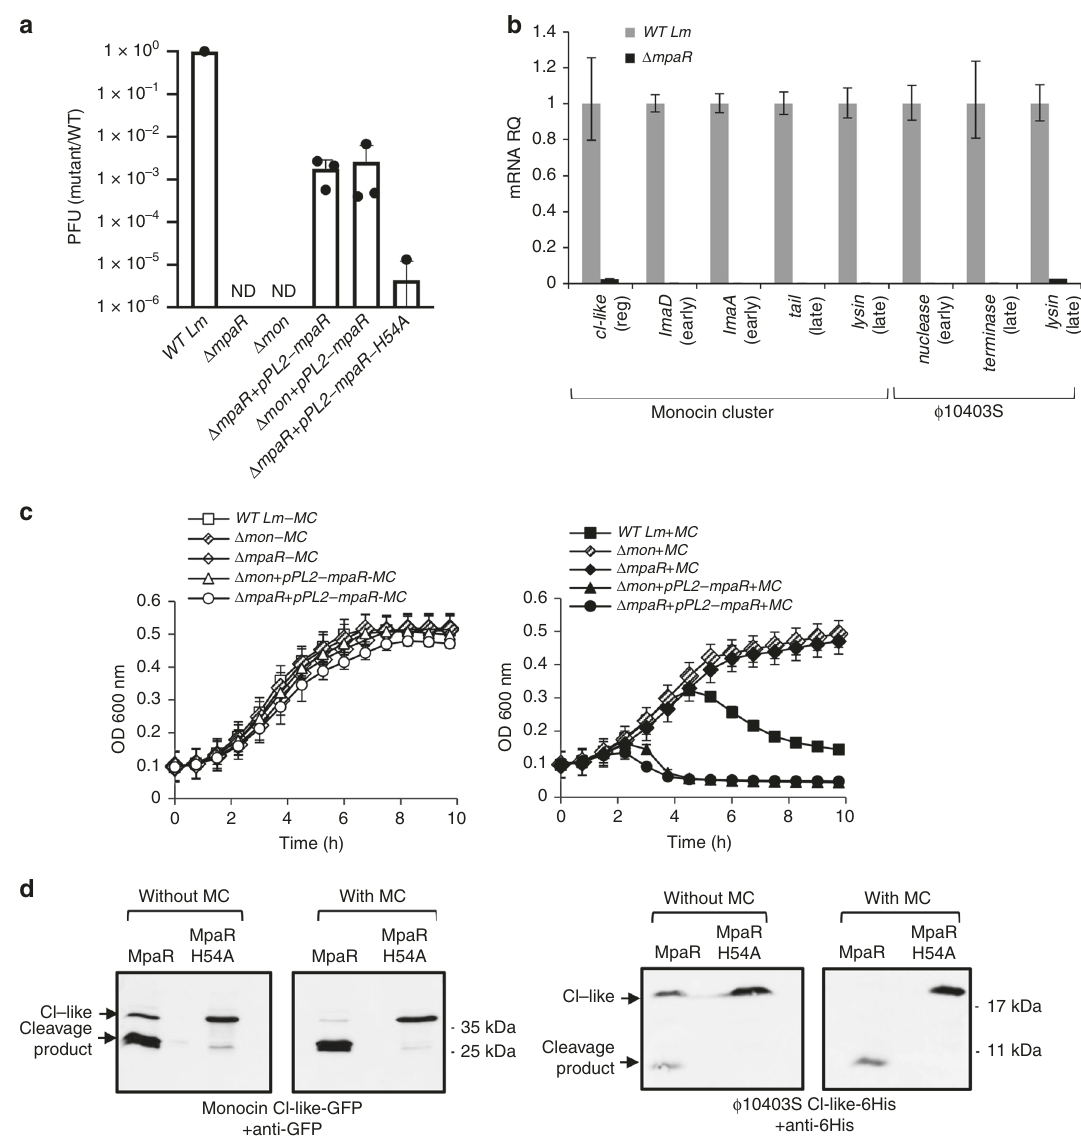
Fig. 4 MpaR functions as an anti-repressor of both monocin and ϕ 10403S. a A plaque forming assay of WT Lm , Δ mpaR and Δ mon mutants, as well as their complemented strains harboring mpaR gene on pPL2 ( Δ mpaR + pPL2- mpaR and Δ mon + pPL2- mpaR , respectively), 4 h post MC treatment at 30 ˚ C. Also included Δ mpaR mutant that was introduced with mpaR -H54A variant on pPL2 ( Δ mpaR + pPL2- mpaR -H54A). The results are normalized to PFU of WT bacteria. Error bars represent standard deviation of 3 independent experiments. b qRT-PCR analysis of transcription levels of indicated genes of monocin- cluster or ϕ 10403S under SOS (4 h post MC treatment at 30 ˚ C) in WT and Δ mpaR bacteria. Transcription levels are represented as relative quantity (RQ), relative to their levels in WT bacteria. The data represent three independent experiments. Error bars indicate a 95% con fi dence interval. c Growth of WT Lm , Δ mpaR and Δ mon , as well as their complemented strains harboring the mpaR gene on pPL2 under the constitutive veg promoter ( Δ mpaR + pPL2- mpaR and Δ mon + pPL2- mpaR , respectively) without (left panel) and with (right panel) MC. The data shows the mean and the standard deviation of three independent biological repeats. d Western blot analysis of CI-like repressors cleavage by MpaR. Δ mon/ Δ ϕ bacteria harboring pPL2 expressing translational fusions of mon-CI-like-GFP (left panel) and ϕ 10403S CI-like-6-His (right panel), in addition to MpaR or MpaR-H54A variant, under the tetR promoter. Equal amounts of total protein from bacteria grown in the presence and absence of MC were separated on 15% SDS-PAGE, blotted and probed with anti- GFP antibodies for mon-CI-like repressor or anti-6His antibodies for ϕ 10403S-CI-like repressor. The experiment was performed 3 times, and the fi gure shows representative blots. Source data are provided as a Source Data fi